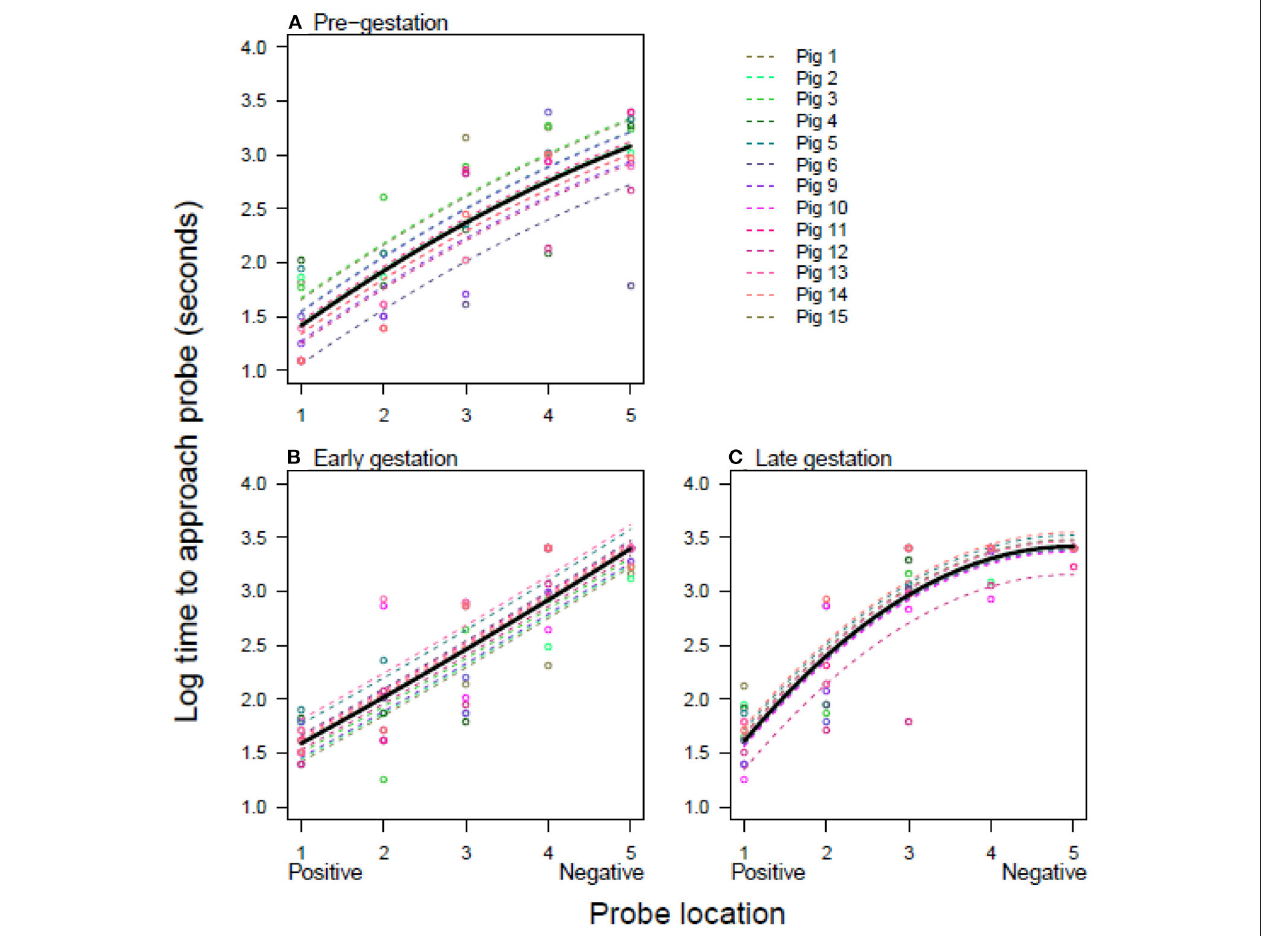
FIGURE 2 | The time to approach each location at three stages of gestation. Log time taken to approach each location for pigs at three different stages of the pig’s 16-week gestational period; (A) pre-gestation, (B) early gestation (5 weeks), and (C) late gestation (10–11 weeks). The open circles are raw data points and the lines are model predictions from the minimal adequate model fixed to the level of experimental replicate 1. Results from model 1 are shown, where the intercept is allowed to vary for each pig at each gestation time. Pigs 1–5 are from replicate 1 and pigs 6–15 are from replicate